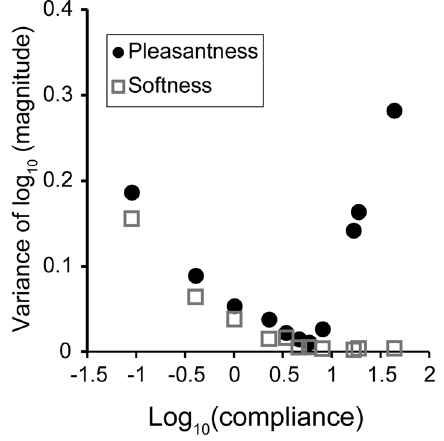
Figure 3. Variance of magnitude estimates. Variances of log 10 magnitude estimates were plotted as a function of log 10 compliance.